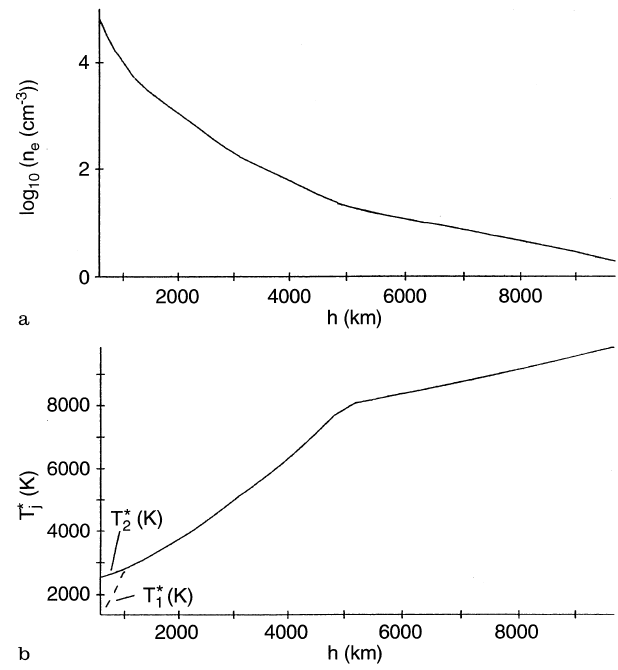
Fig. 1. a Electron density n e and b temperatures T (cid:3) (cid:133) j (cid:136) 1 (cid:134) and electrons (cid:133) j (cid:136) 2 (cid:134) versus altitude h obtained for the background plasma located above the nightside auroral ionosphere by averaging of experimental data (Liperovsky and